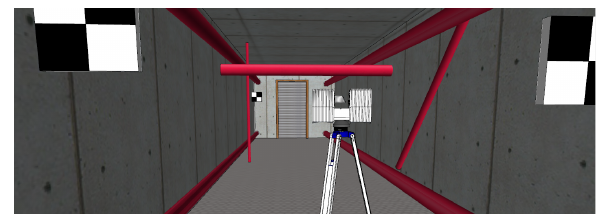
Figure 4: First case: a typical industrial corridor. The scene includes planes, cylinders and targets from which we select 3 points, 7 lines and 5 planes.